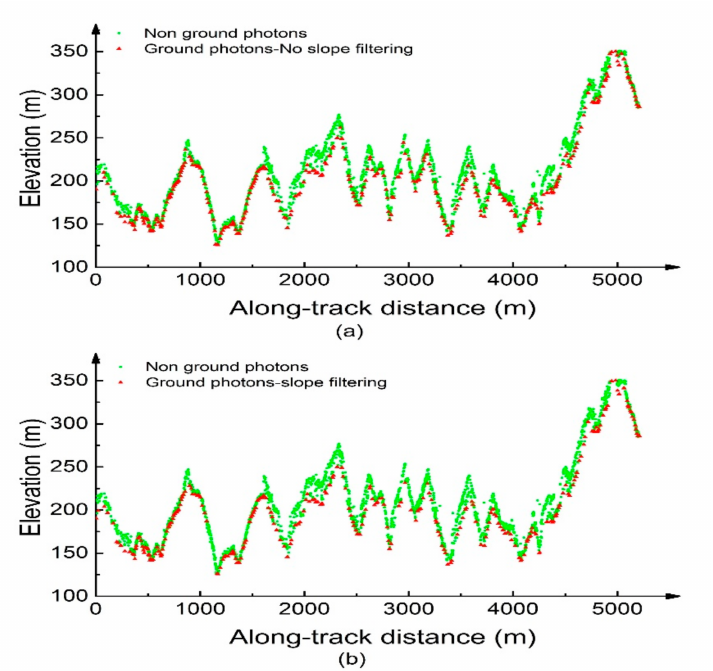
Figure 7. The distribution map of the ground points before and after slope filtering: ( a ) without slope filtering; ( b ) after slope